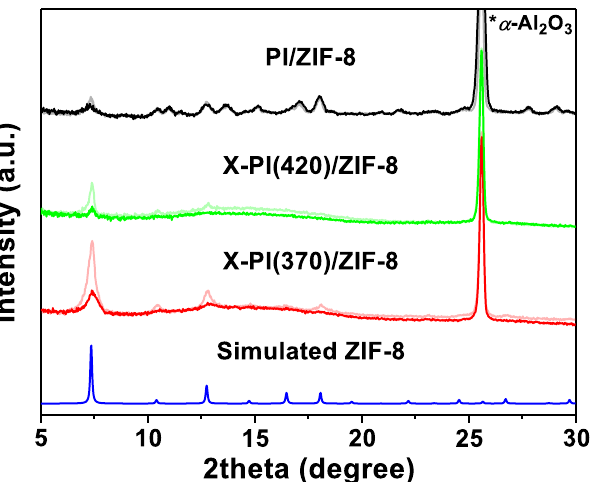
Figure 4. XRD patterns of X-PI(370)/ZIF-8, X-PI(420)/ZIF-8, and PI/ZIF-8. The overlapped lines in lighter colors are the diffraction patterns of the samples before acid treatment and presented for a comparison purpose.